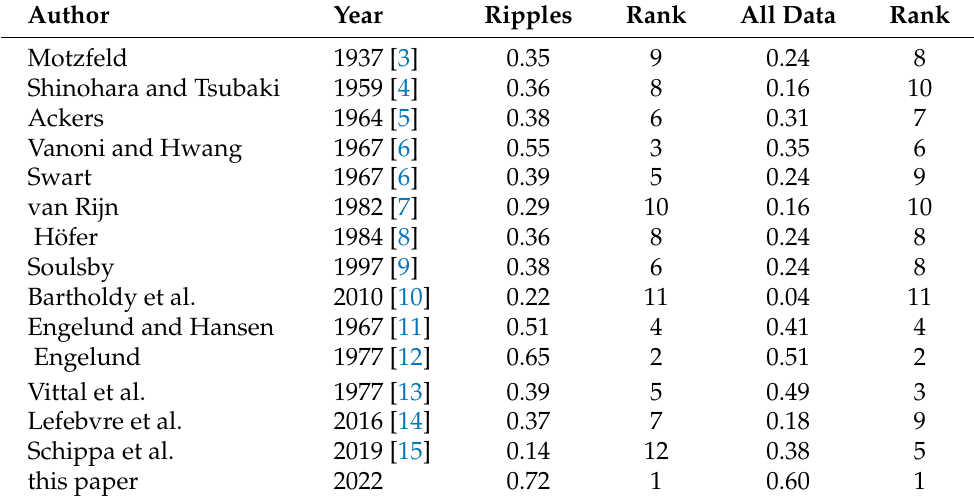
Table 7. Quality of the different